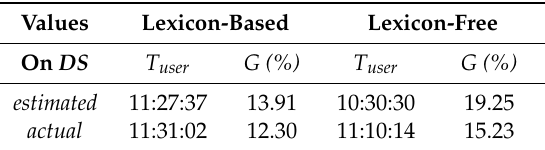
Table 5. Comparison between the values provided by our model and the actual ones on DS . Times are expressed in the format